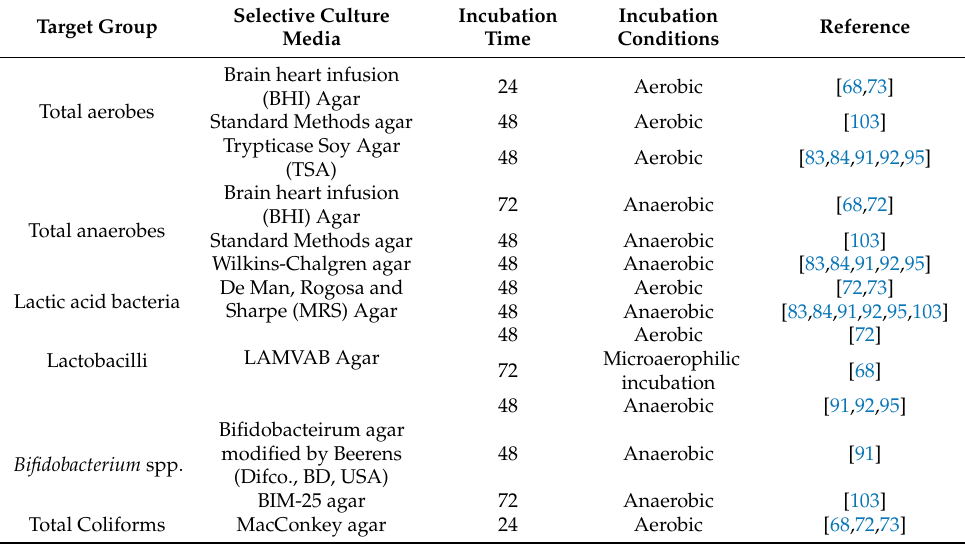
Table 5. Culture media used for analysis of microbial